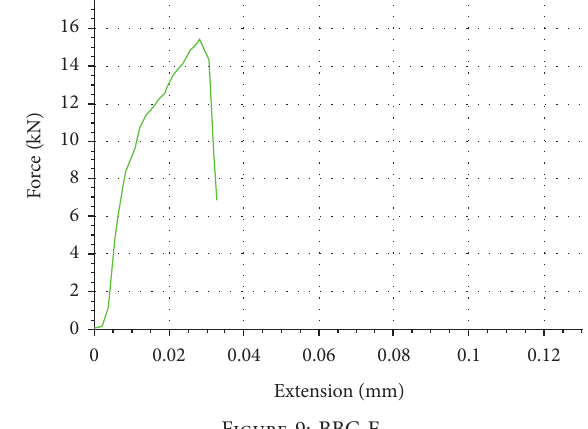
Figure 12: Impact strength of composite samples.